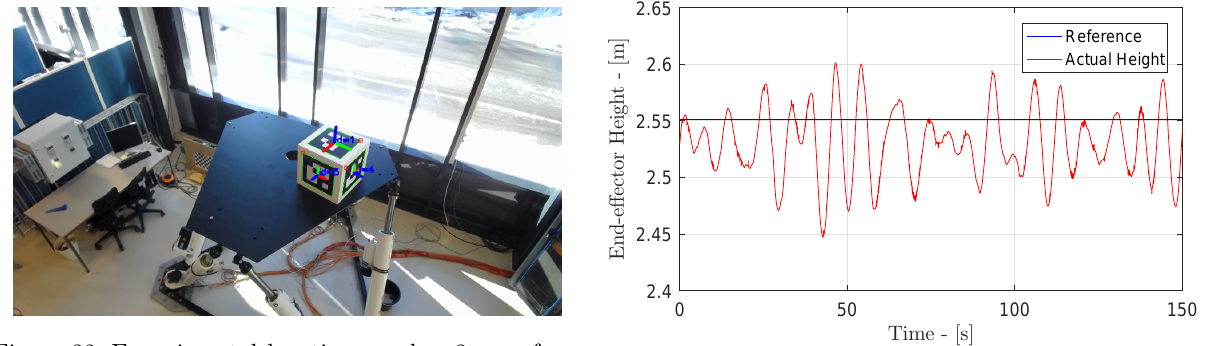
Figure 22: Experimental location number 2 seen from the camera.